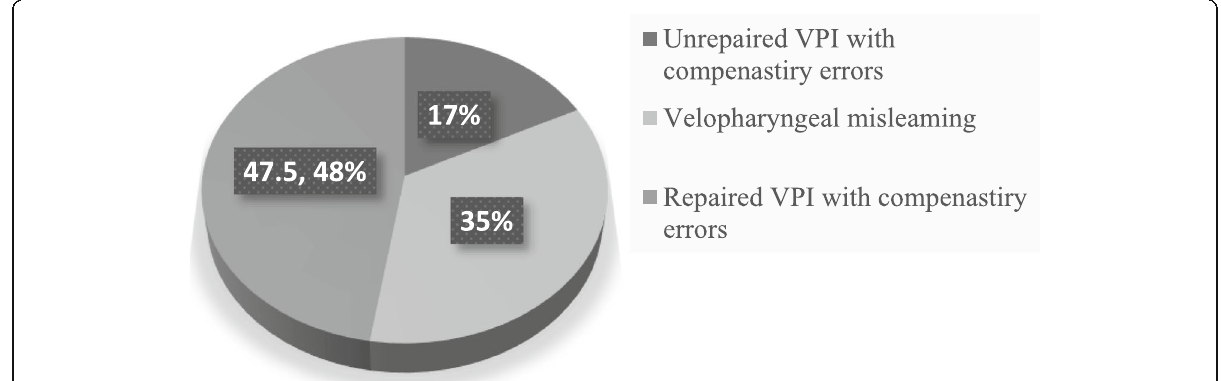
Fig. 1 Distribution of the sample according to the